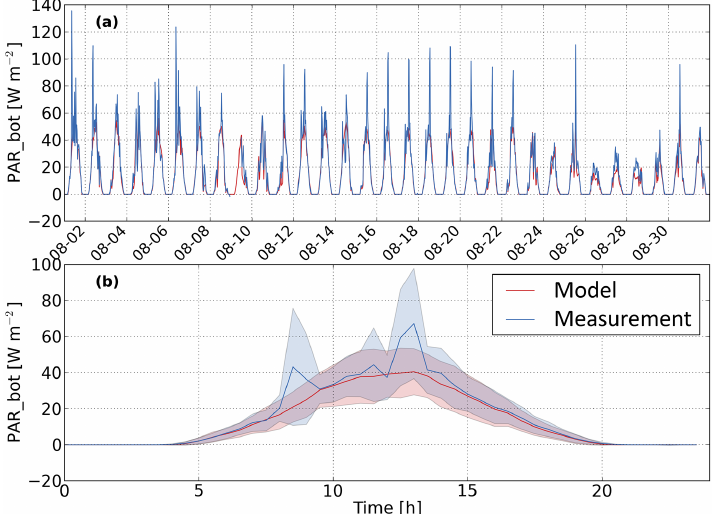
Figure 4. (a) Time series of PAR at 0.6m from model (red) and measurement (blue) in August 2010. (b) The monthly averaged diurnal cycle of time series in (a) for model (red) and measurement (blue). The range of ± 1SD is marked by the shade with the same colour.